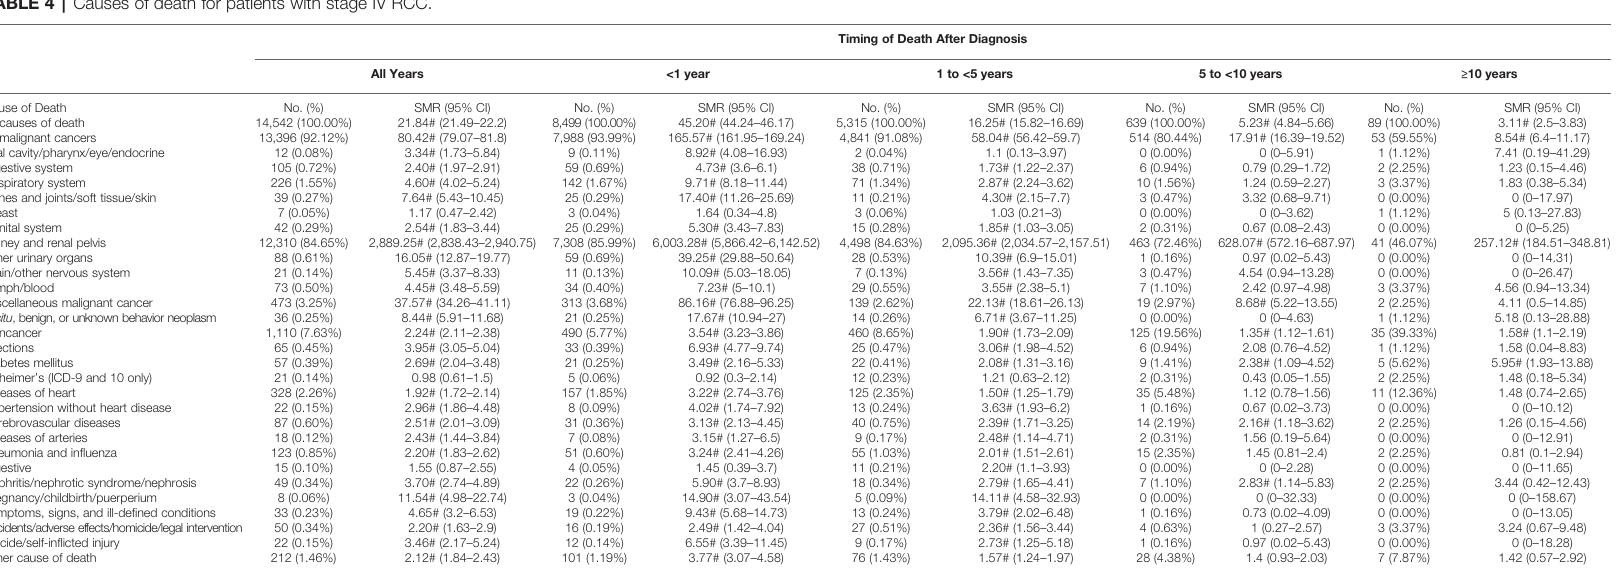
TABLE 4 | Causes of death for patients with stage IV